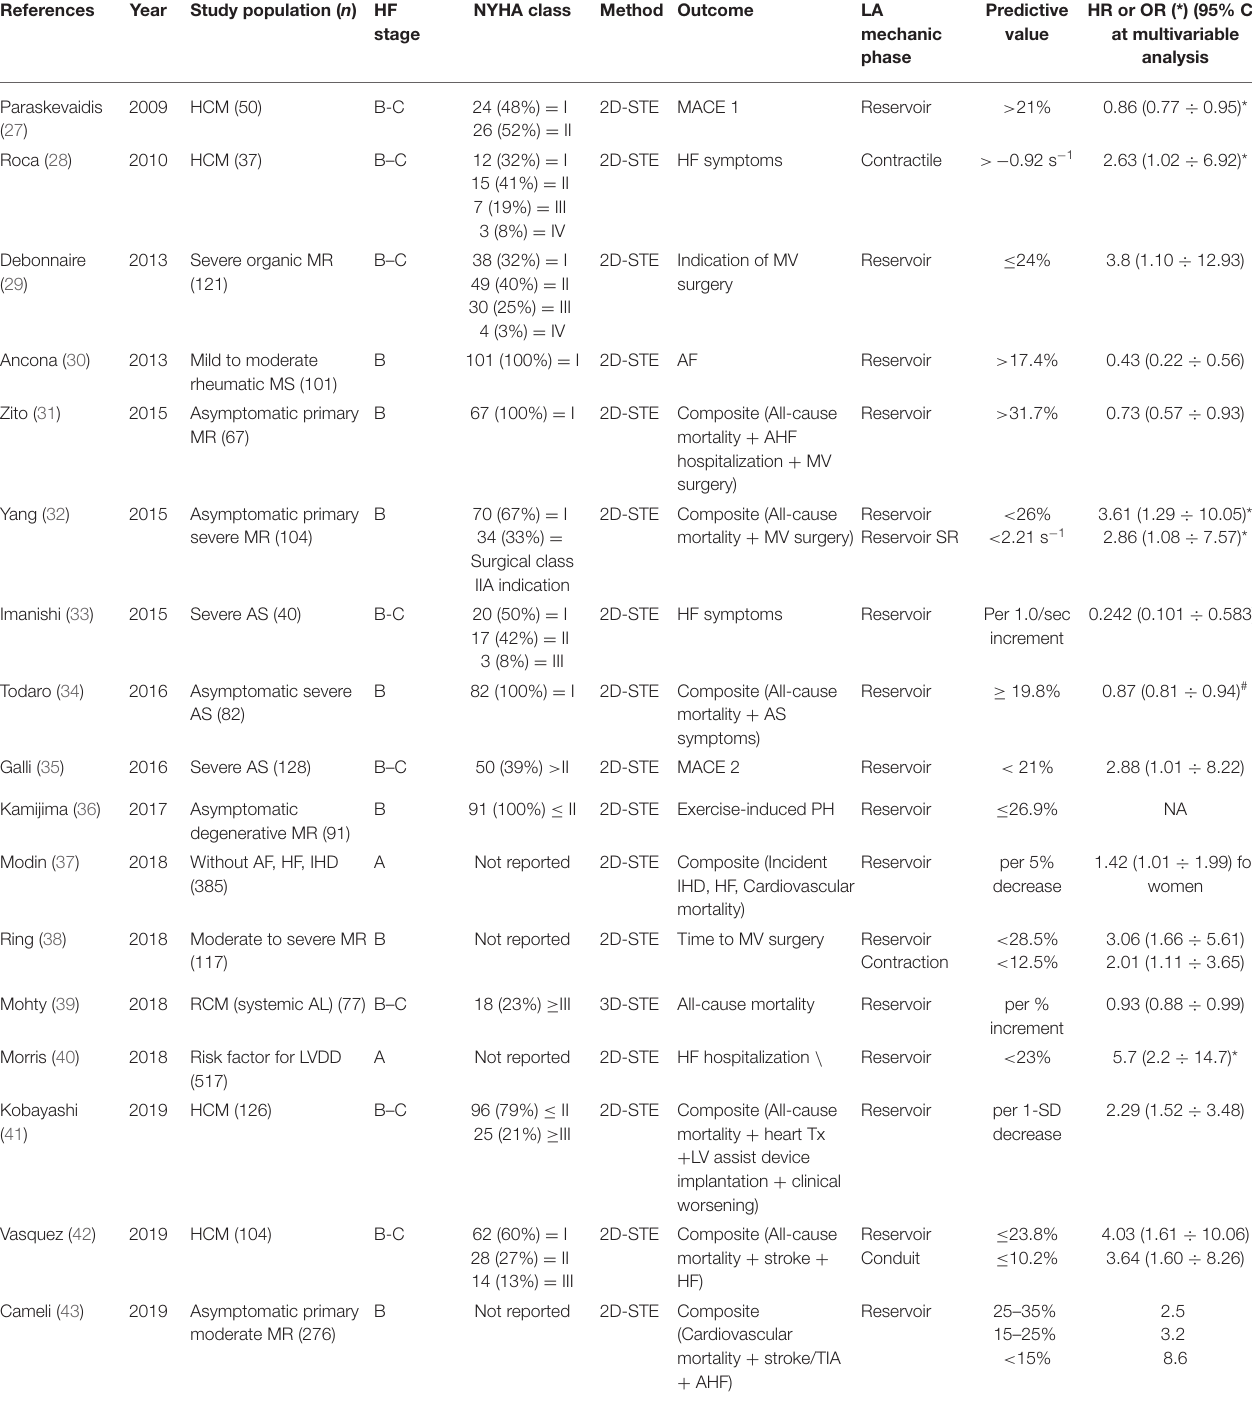
TABLE 2 | Summary of studies showing the prognostic value of LA mechanics in patient at risk of heart failure (HF; stage A) or with cardiac structural abnormalities (stage B) with respect to hard and soft